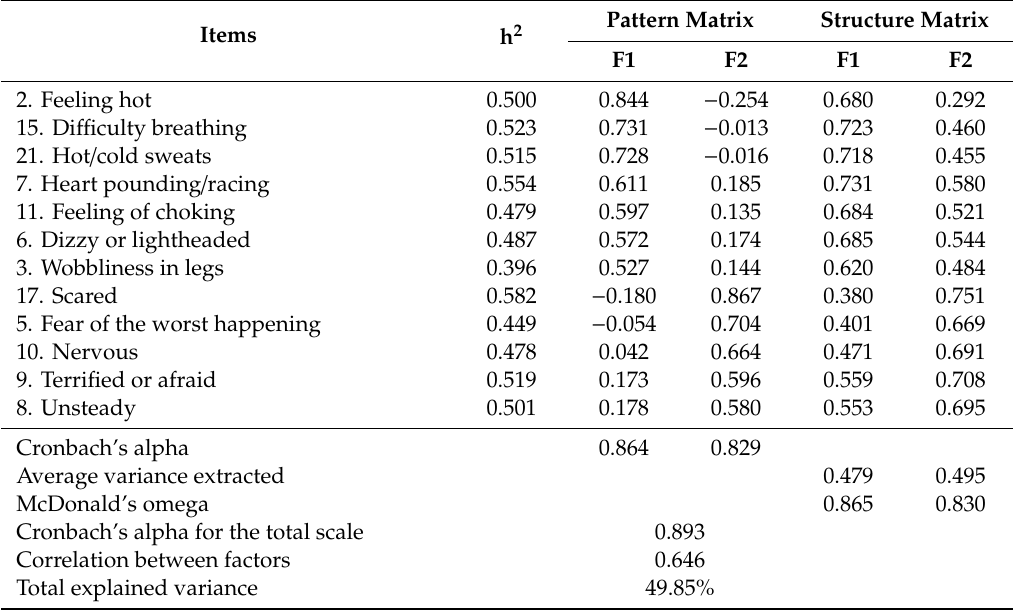
Table 4. Factorial structure of 12 BAI items explored in the subsample of 224 participants. Pattern Items h 2